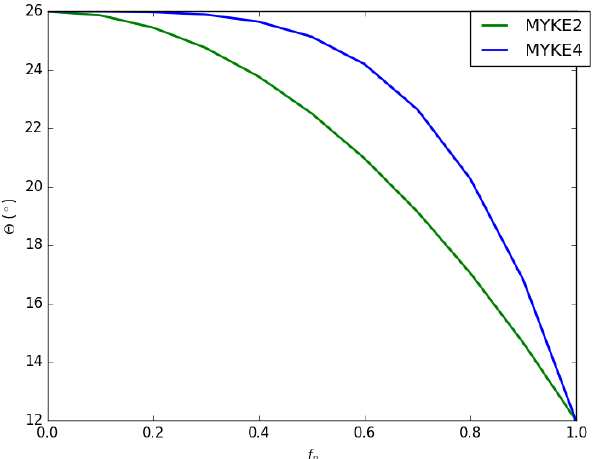
Figure 2. Model domain (yellow) used in this study centered over Fairbanks with a horizontal resolution of 10km. The cities of Barrow (now Utqiagvik; 71 . 18 ◦ N,156 . 44 ◦ E) and Fairbanks (64 . 83 ◦ N,147 . 77 ◦ E) over which the F12, F13, F21 and F29 flights took place are also shown with orange